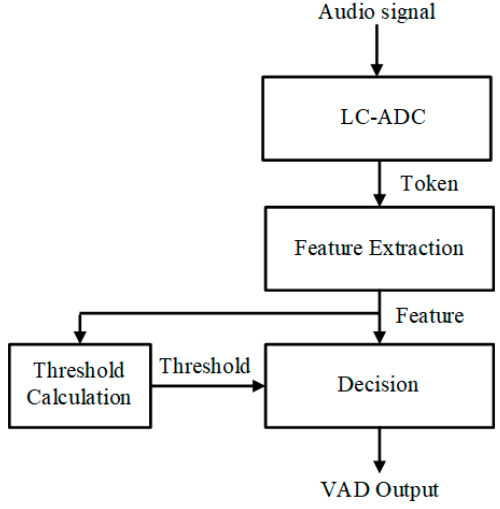
Figure 5. Block diagram of the proposed VAD algorithm.